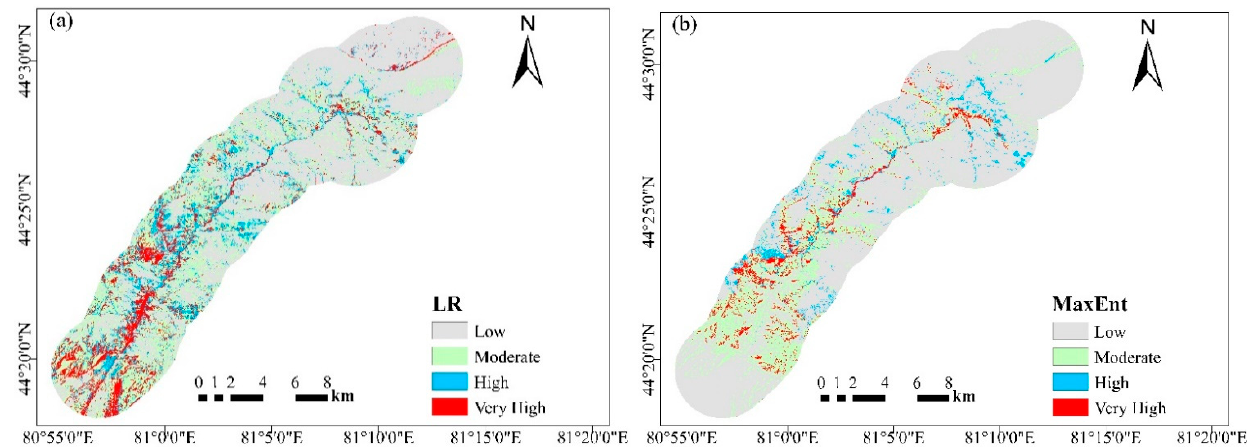
Remote Sens. 2022 , 14 , 3620 Figure 6. Landslide susceptibility maps generated applying the ( a ) LR and ( b ) MaxEnt models.